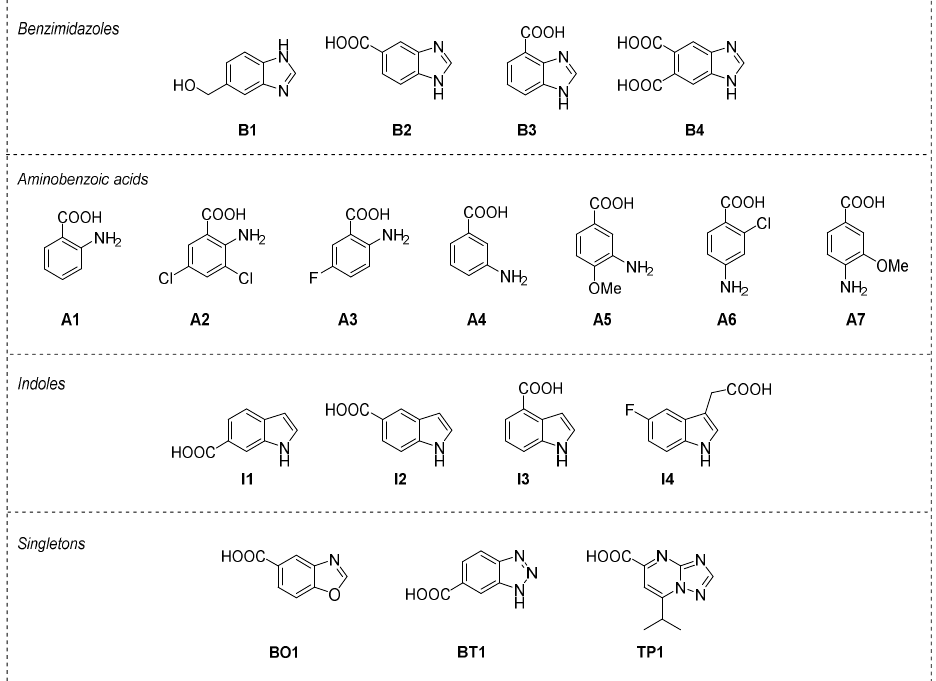
Figure 4. Fragments selected for experimental validation (i.e., thermal shift assay) grouped by chemotype: benzimidazoles ( B1 – B4 ), aminobenzoic acids ( A1 – A7 ), indoles ( I1 – I4 ), and the three singletons ( BO1 , BT1, and TP1 ).